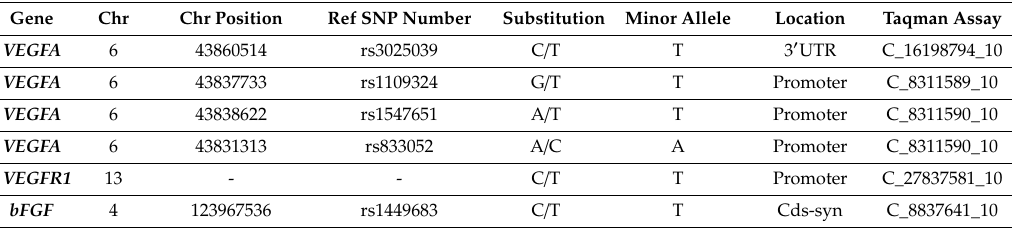
Table 2. Characteristics of the analyzed